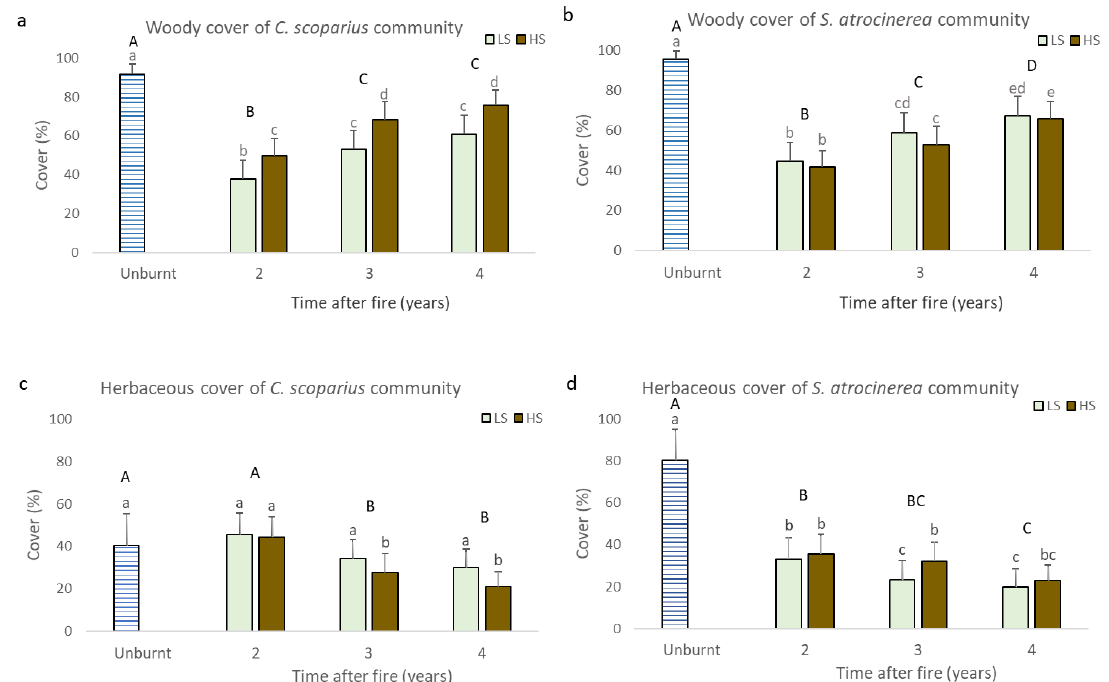
Figure 2. The horizontal cover of woody and herbaceous species reached in unburnt areas and burned burned areas 2, 3, and 4 years after fire with di ff erent fire severity levels in C. scoparius and S. atrocinerea areas 2, 3, and 4 years after fire with different fire severity levels in C. scoparius and S. atrocinerea communities. a: woody cover of C. scoparius community, b: woody cover of S. atrocinerea community, communities. a ): woody cover of C. scoparius community, b ): woody cover of S. atrocinerea c: herbaceous cover of C. scoparius community, d: herbaceous cover of S. atrocinerea community, HS: community, c ): herbaceous cover of C. scoparius community, d ) : herbaceous cover of S. atrocinerea high severity, LS: low severity. Di ff erent lowercase letters indicate di ff erences between severities and community, HS: high severity, LS: low severity. Different lowercase letters indicate differences di ff erent uppercase letters indicate di ff erences between unburnt and post-fire between severities and different uppercase letters indicate differences between unburnt and post-fire years.